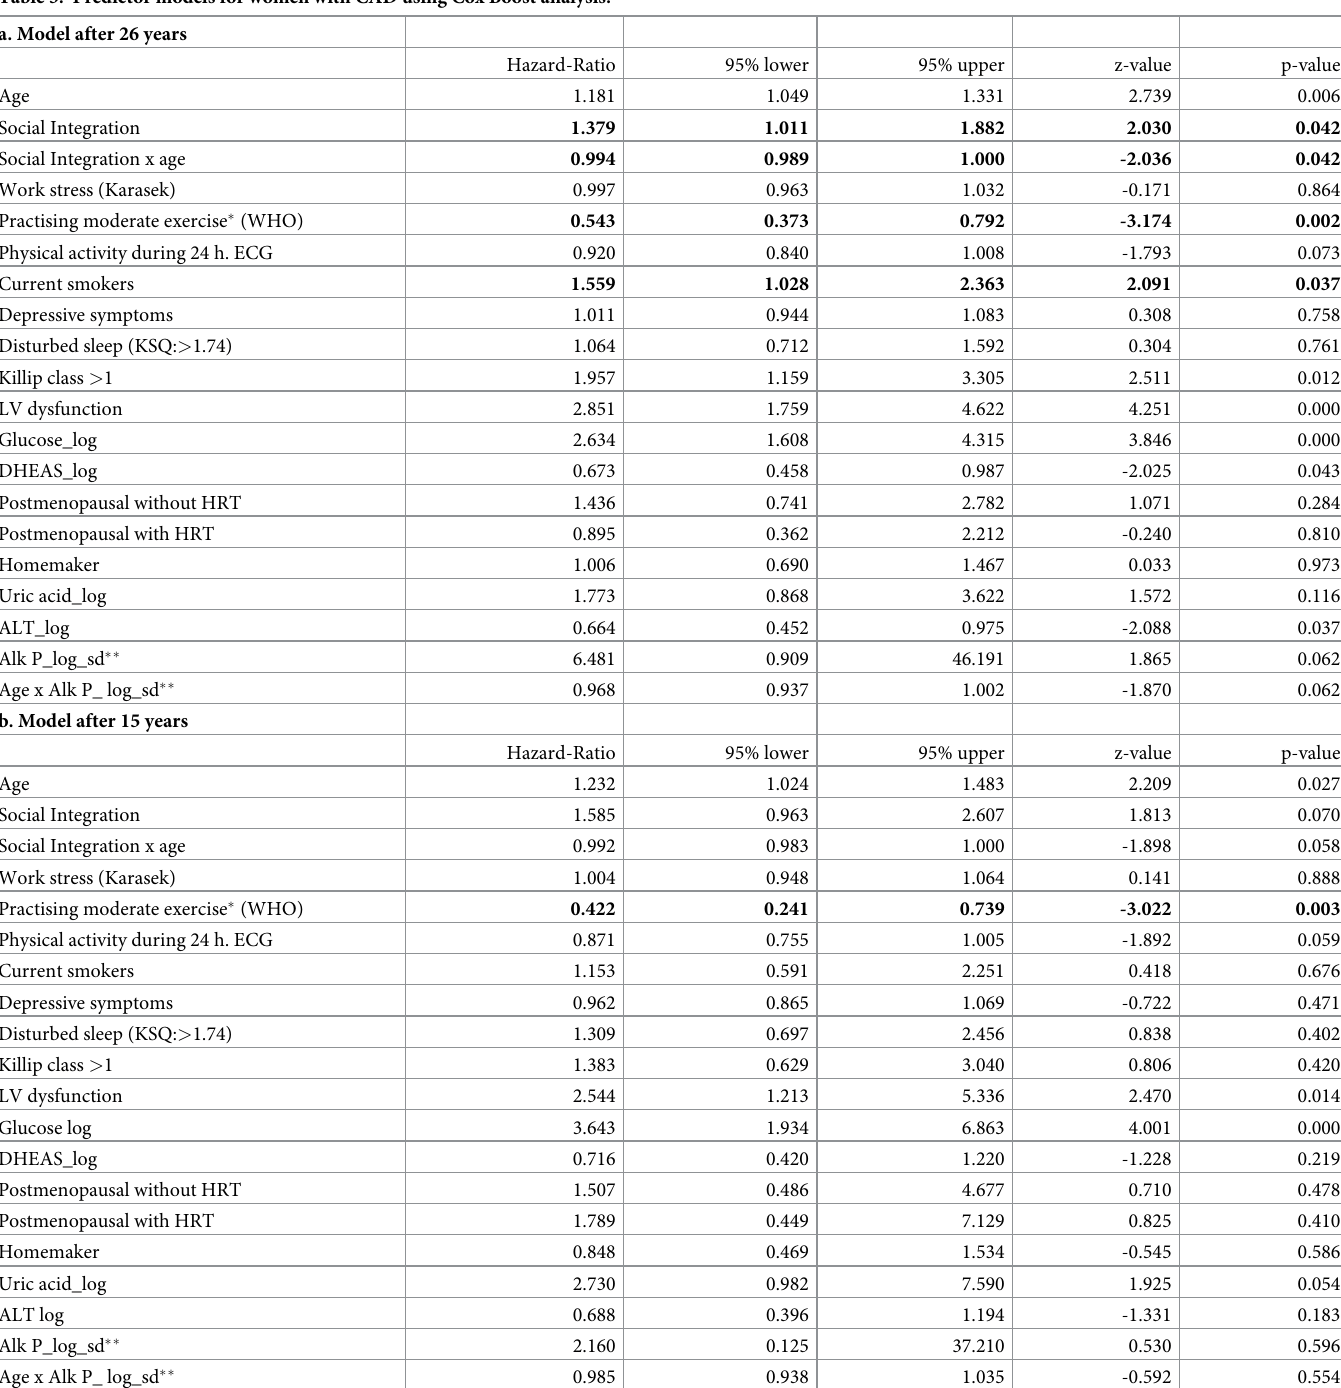
Table 3. Predictor models for women with CAD using Cox Boost